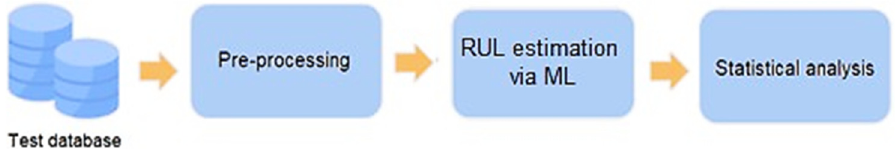
Figure 8. Testing of the RUL model estimation for each RUT [authors].